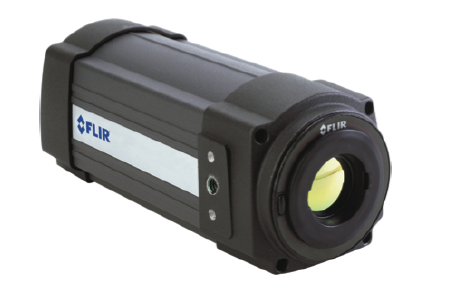
Figure 5. FLIR A-300. Table 1. Characteristics of the IR thermographic sensor FLIR A-300.